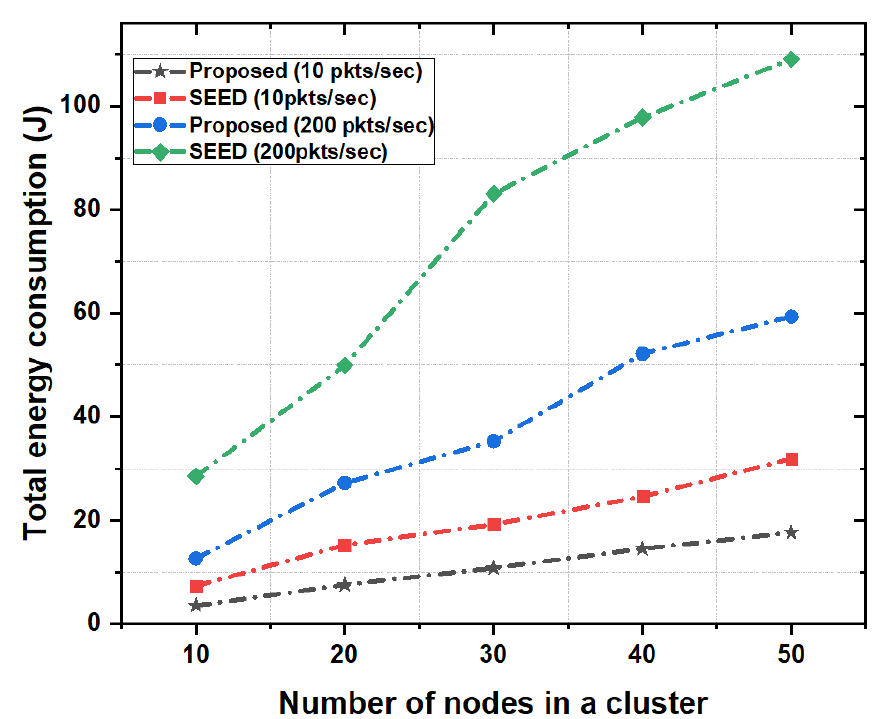
Figure 10. Total energy consumption as a function of the number of nodes in a